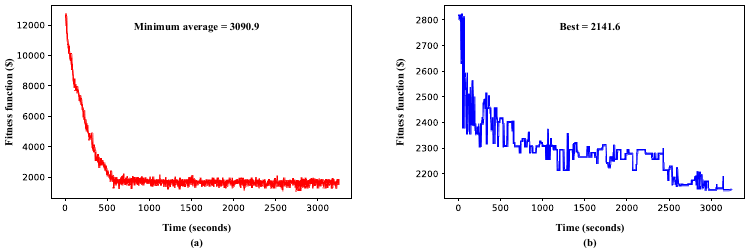
Fig. 11. (a) The change of the average fitness function of GA with time for the normal demand fulfillment, (b) The change of the best fitness function of GA with time for the normal demand